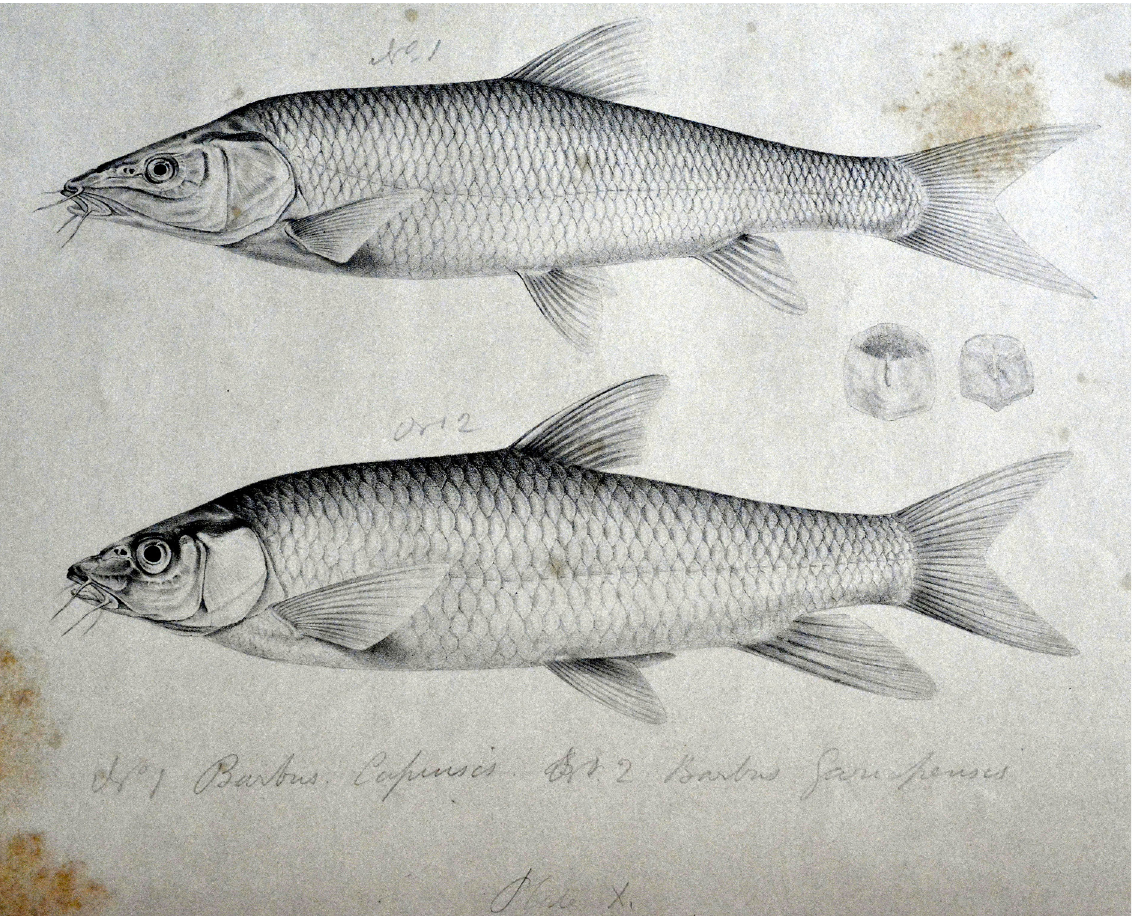
Fig. 7. Proof sheet of plate X, annotated by Andrew Smith in the R.T. Günther Collection (A649), Cullen Library, University of Witwatersrand. Photograph by